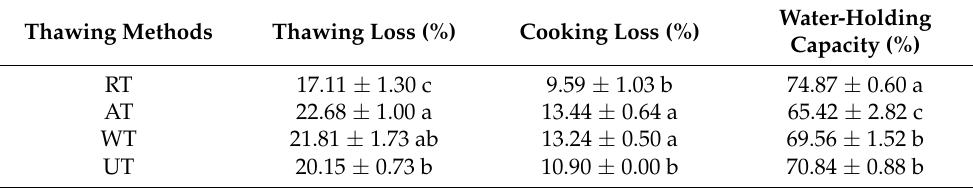
Table 1. Influence of thawing methods on the thawing loss, cooking loss, and water-holding capacity of frozen instant sea cucumber.